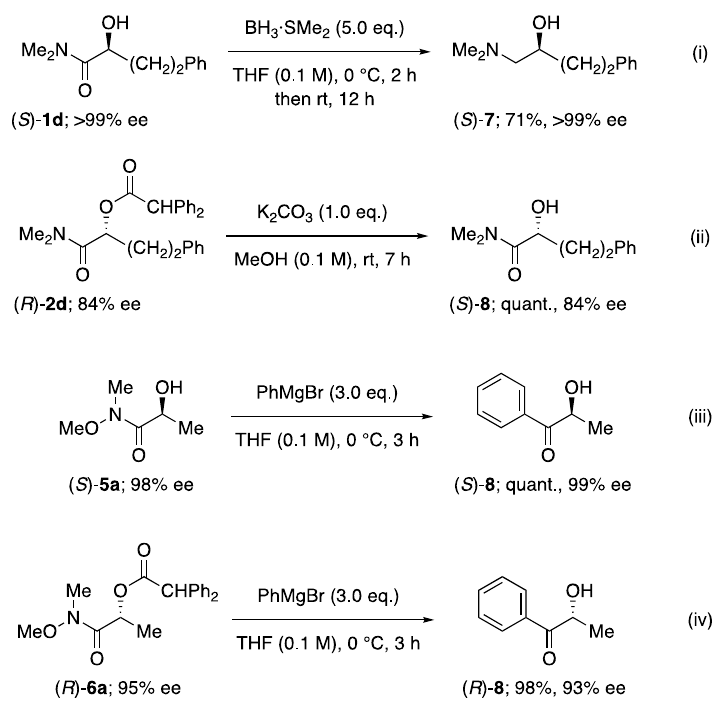
Scheme 4. Transformation of chiral 2-hydroxyamides and their